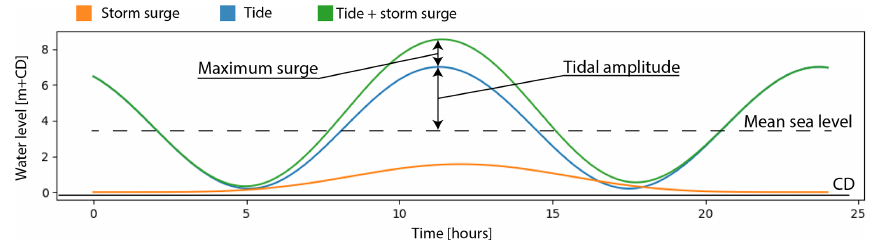
Figure 3. Example time series of coastal storm surge event. Orange: run up due to storm surge; blue: elevation of tide; green: total elevation of tide plus surge.